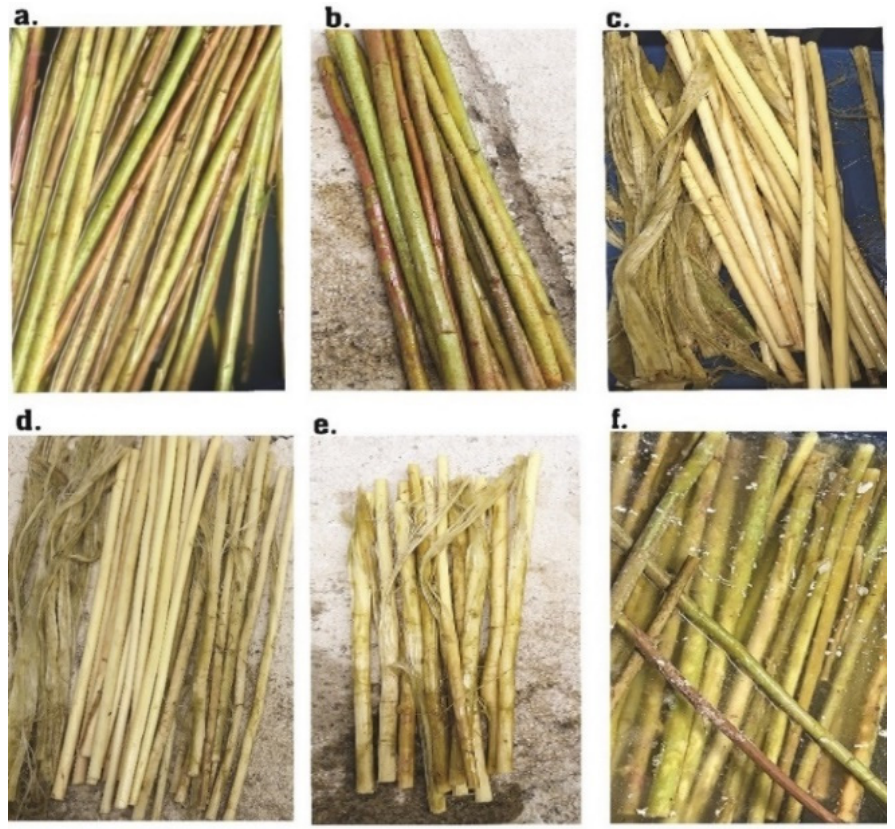
Figure 4. Augmented retting effect on kenaf plants. ( a ) Uninoculated with FW; ( b ) Uninoculated with SW. ( c ) APPB1 with SW. ( d ) APPB1 with FW. ( e ) APPB2 with SW. ( f ) APPB2 with FW.